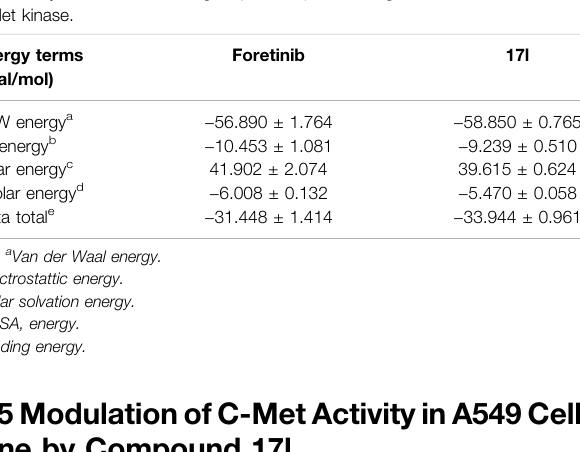
Frontiers in Chemistry |